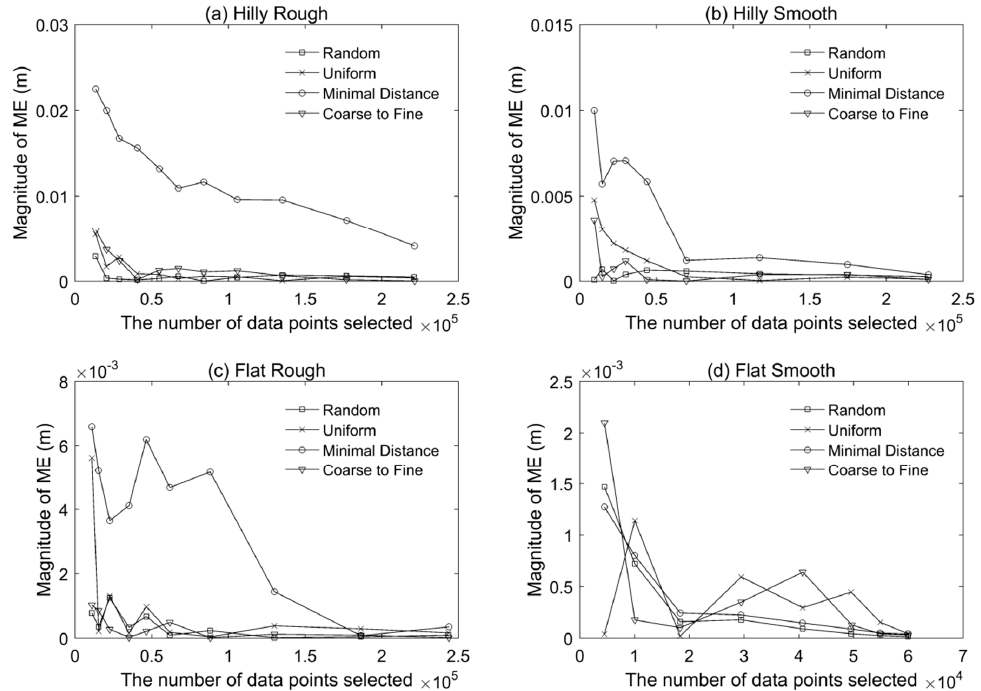
Figure 6. The magnitude of mean error (ME) versus the number of data points of thinned point clouds for the four terrain surfaces: ( a ) hilly rough, ( b ) hilly smooth, ( c ) flat rough, and ( d ) flat smooth.